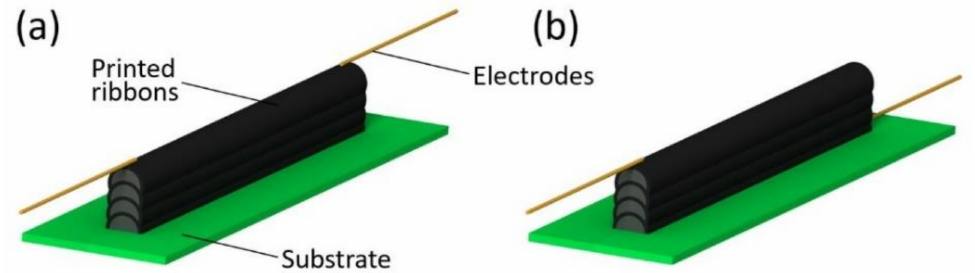
Figure 3. Scheme of electrode configuration for studying the effect of the interface between layers on the electrical conductivity of printed circuits. ( a ) electrodes placed in the same layer and ( b ) electrodes placed in the first and last printed layers.